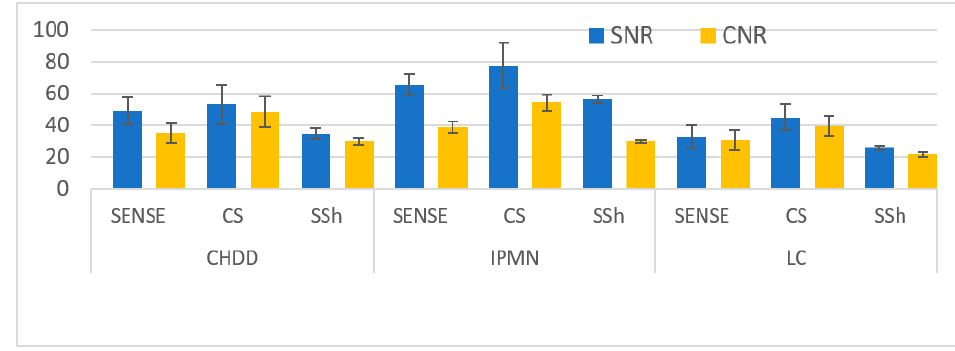
Figure 4. Statistical plots for SNR and CNR values in Patient’s MRCP Images.